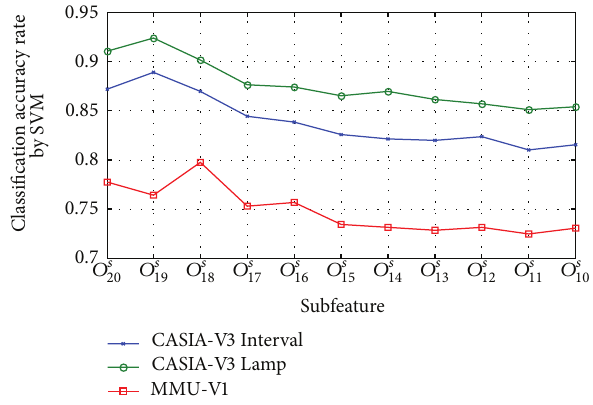
Figure 14: Classification accuracy of subfeature based on orienta- tion selection by SVM classifier.